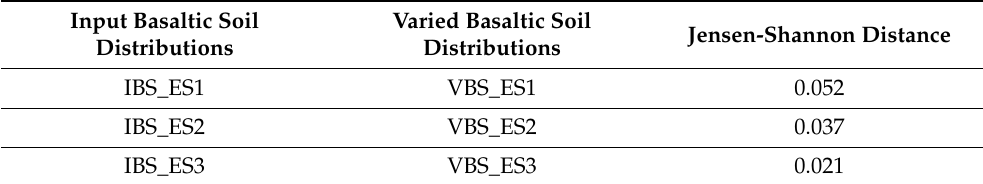
Table 6. Jensen–Shannon distances between input basaltic soil distributions and varied basaltic soil distributions. Input Basaltic Soil Varied Basaltic Soil Distributions